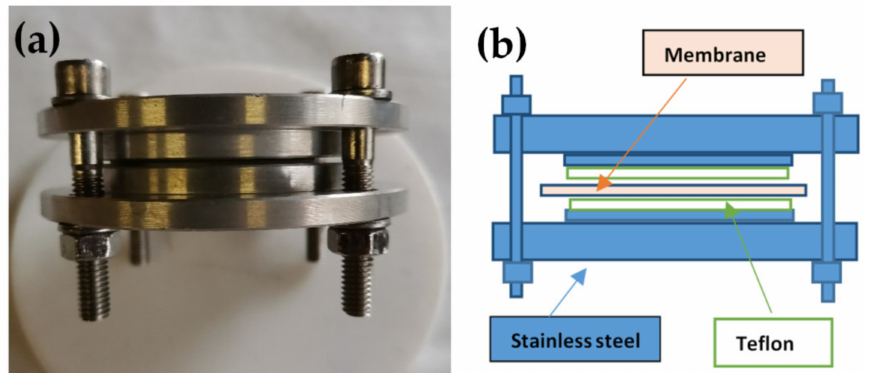
Figure 1. ( a ) Photo and ( b ) schematic representation of the device used for the preparation of Nafion 117